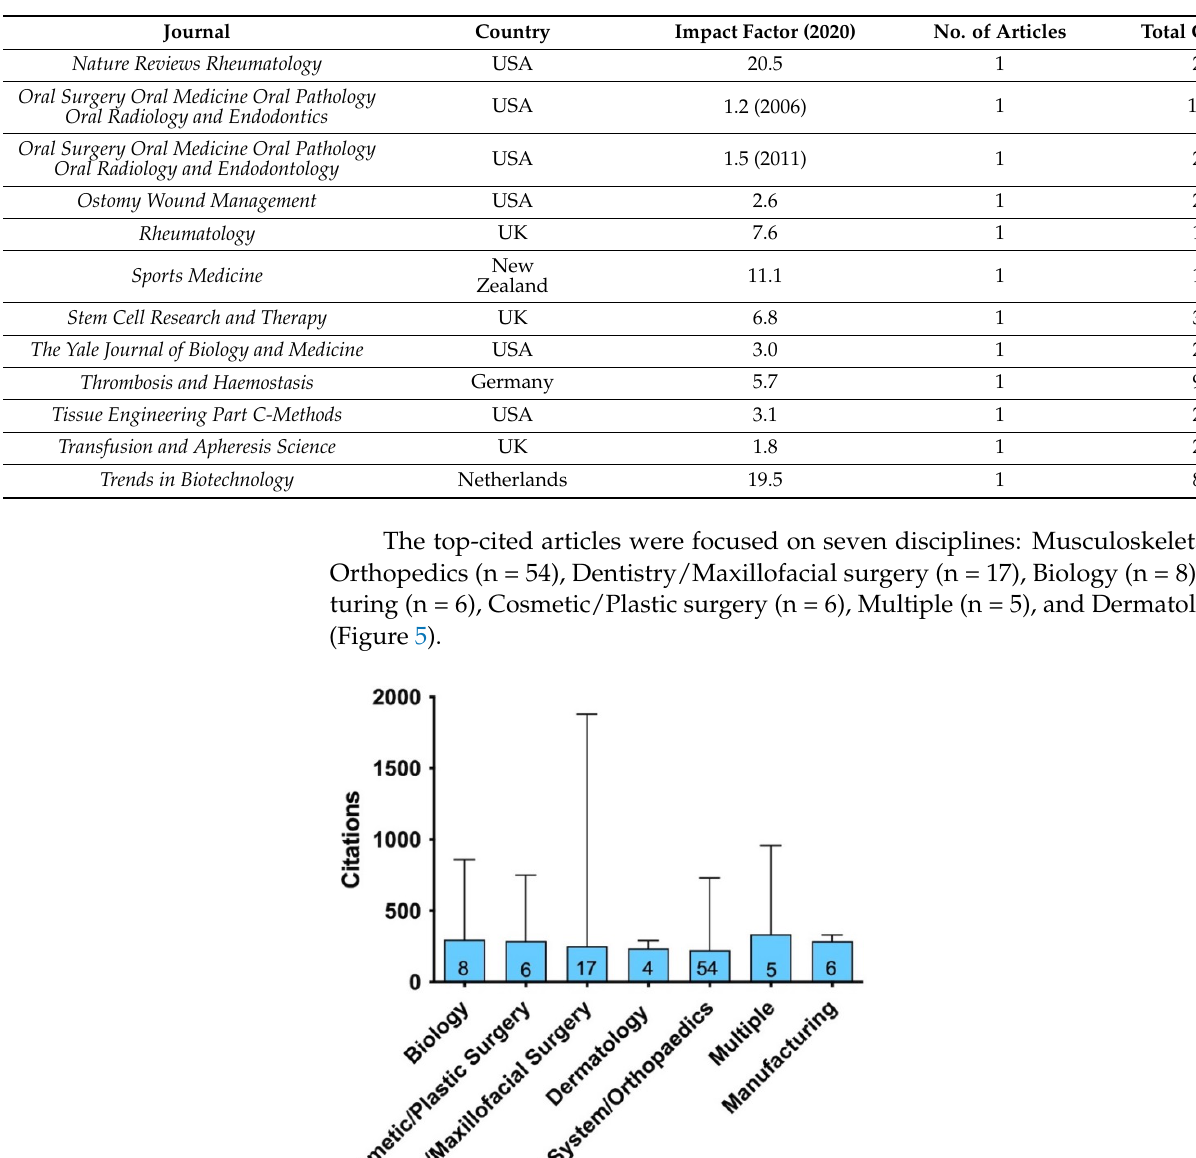
Figure 5. Theme distribution of articles. Bar graph showing the median number of citations (and maximum) for the most-cited articles according to the theme distribution of articles (number of articles at the bottom of the bar).